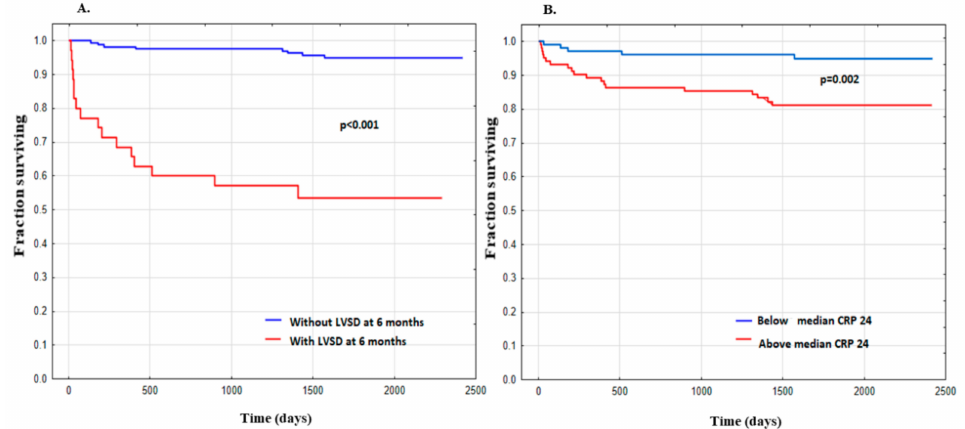
Figure 4. Kaplan–Meier analysis showing survival free from hospitalization for heart failure in long-term follow-up in groups of patients: ( A ) with ( n = 35) and without ( n = 164) left ventricular systolic dysfunction (LVSD) 6 months post-ST-segment elevation myocardial infarction; ( B ) with the concentration of CRP 24 h after admission (CRP 24 ) for ST-segment elevation myocardial infarction below ( n = 102) or above ( n = 102) median